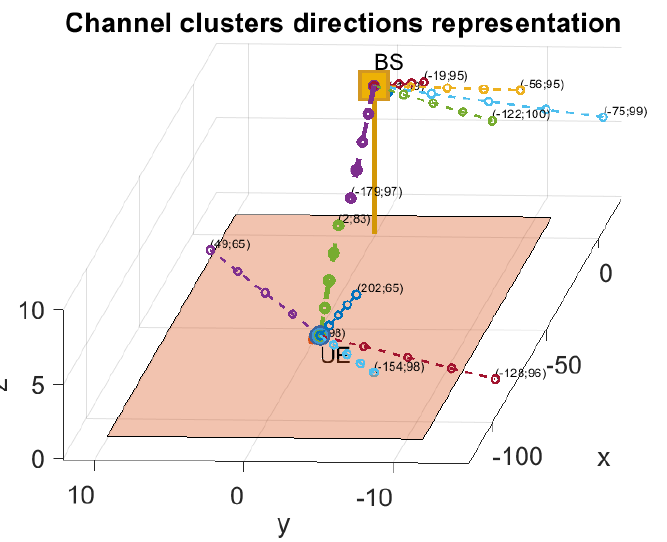
Figure 4. Representation of the main clusters angles for a UT–BS link w.r.t. their powers and directions, in case of LOS